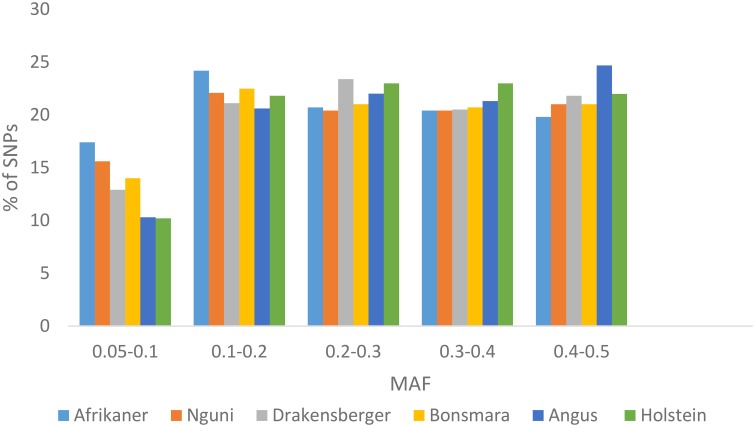
Minor allele frequencies for SNPs that passed quality control by breed.